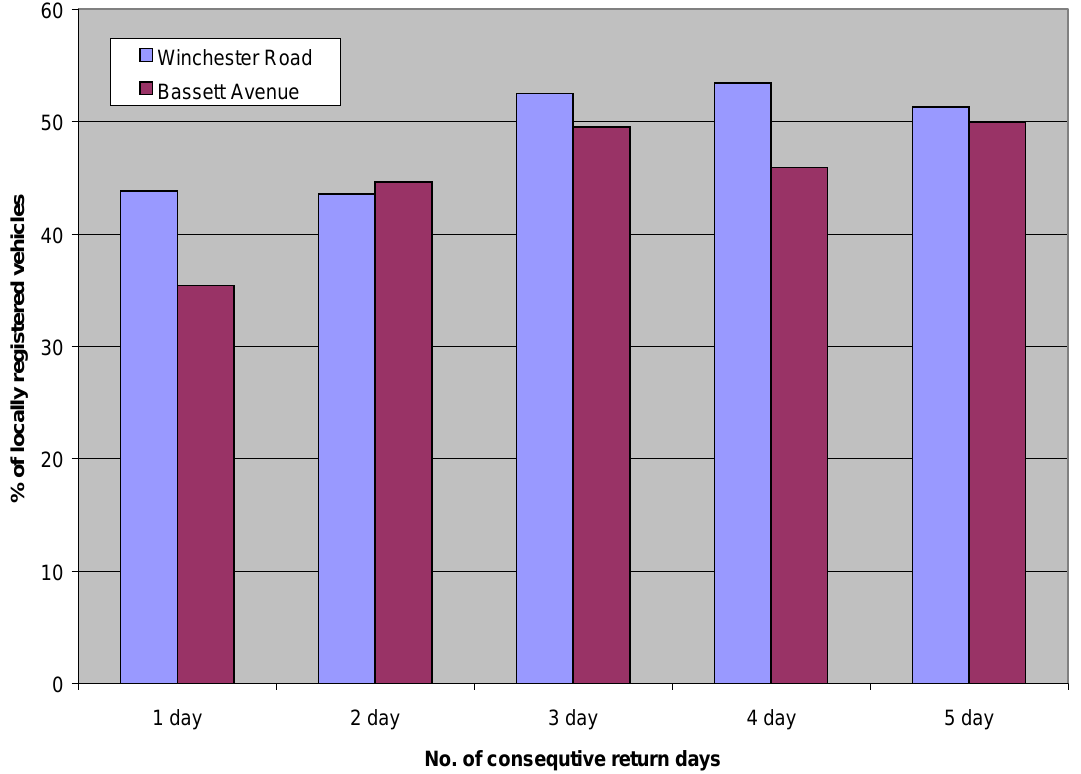
Figure 4. The percentage of locally registered vehicles observed returning over the five-day survey periods in the 1996 Winchester Road and Bassett Avenue